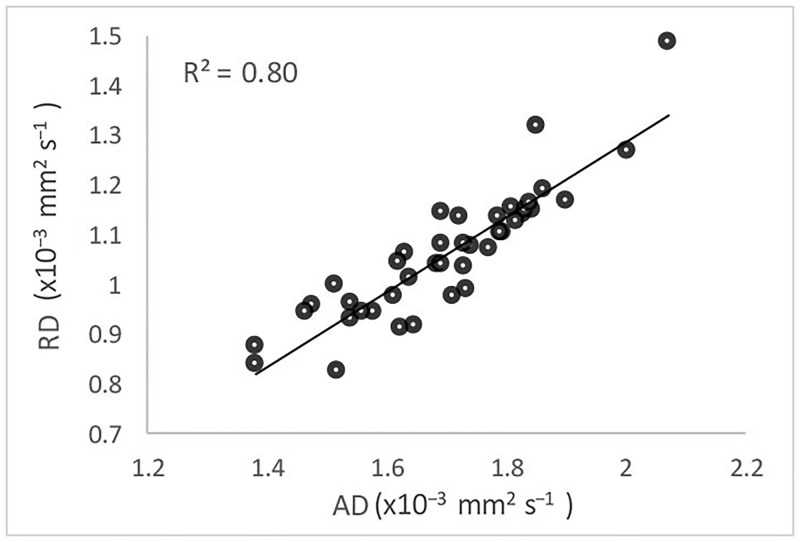
Correlation between AD and RD in OR lesions.